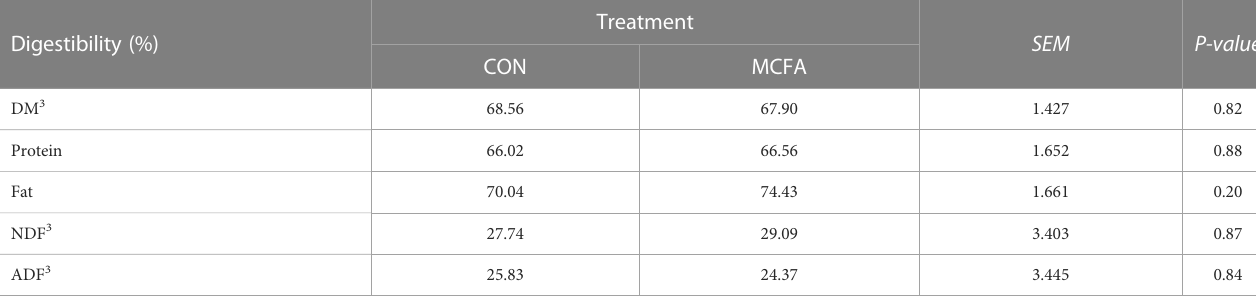
TABLE 4 Effects of feeding medium-chain fatty acid on nutrient digestibility of the peak lactation cows.